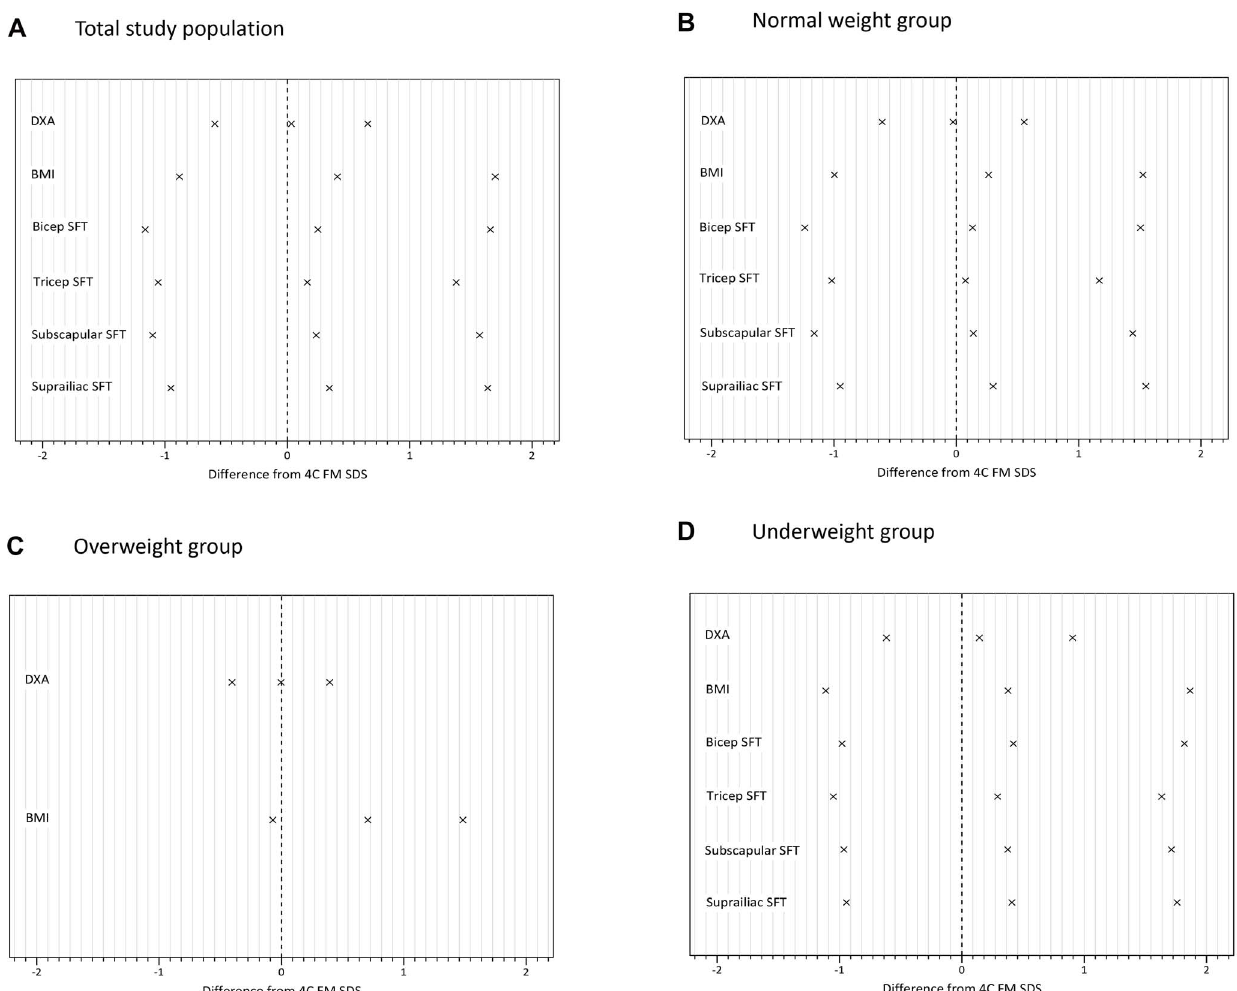
Figure 3. Mean bias and limits of agreement of each ‘simple’ method for measuring fat mass (FM) when compared to the 4C (4 compartment) model: (A) total study population; (B) normal weight group; ((C) overweight group; (D) underweight group. Difference from 4C FM SDS is calculated by subtracting the 4C FM SDS from that of the simple method. Limits of agreement are calculated as mean bias 6 2 standard deviations (SDs). DXA; dual-energy X-ray absorptiometry, BMI; body mass index, SFT; skinfold thickness. Evaluation of SFT as a measurement of FM was carried out using a limited population consisting of study groups DX, PT and CF. The OB, GSD, ALL and ED studies did not include SFT measurement as part of their protocols. Since no subjects were available for the overweight disease group, normal subjects were compared to underweight subjects only.